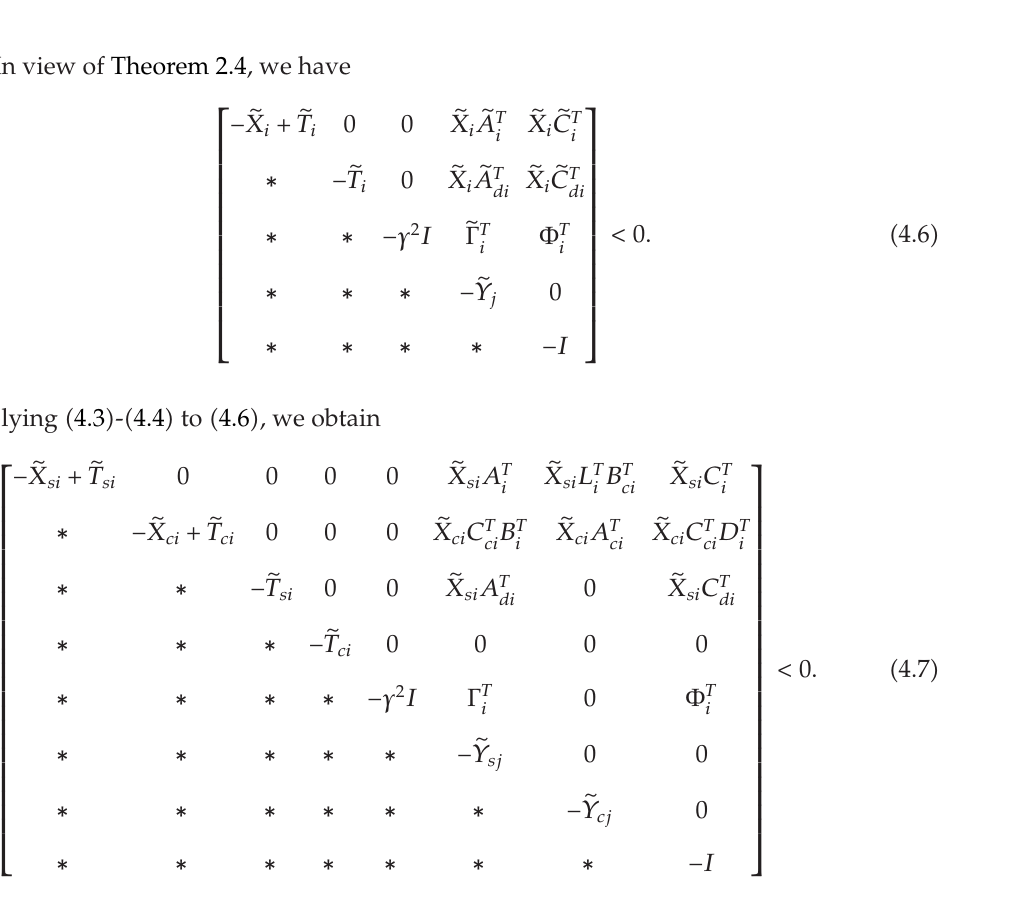
Figure 7: Output signal of the closed-loop switched discrete time